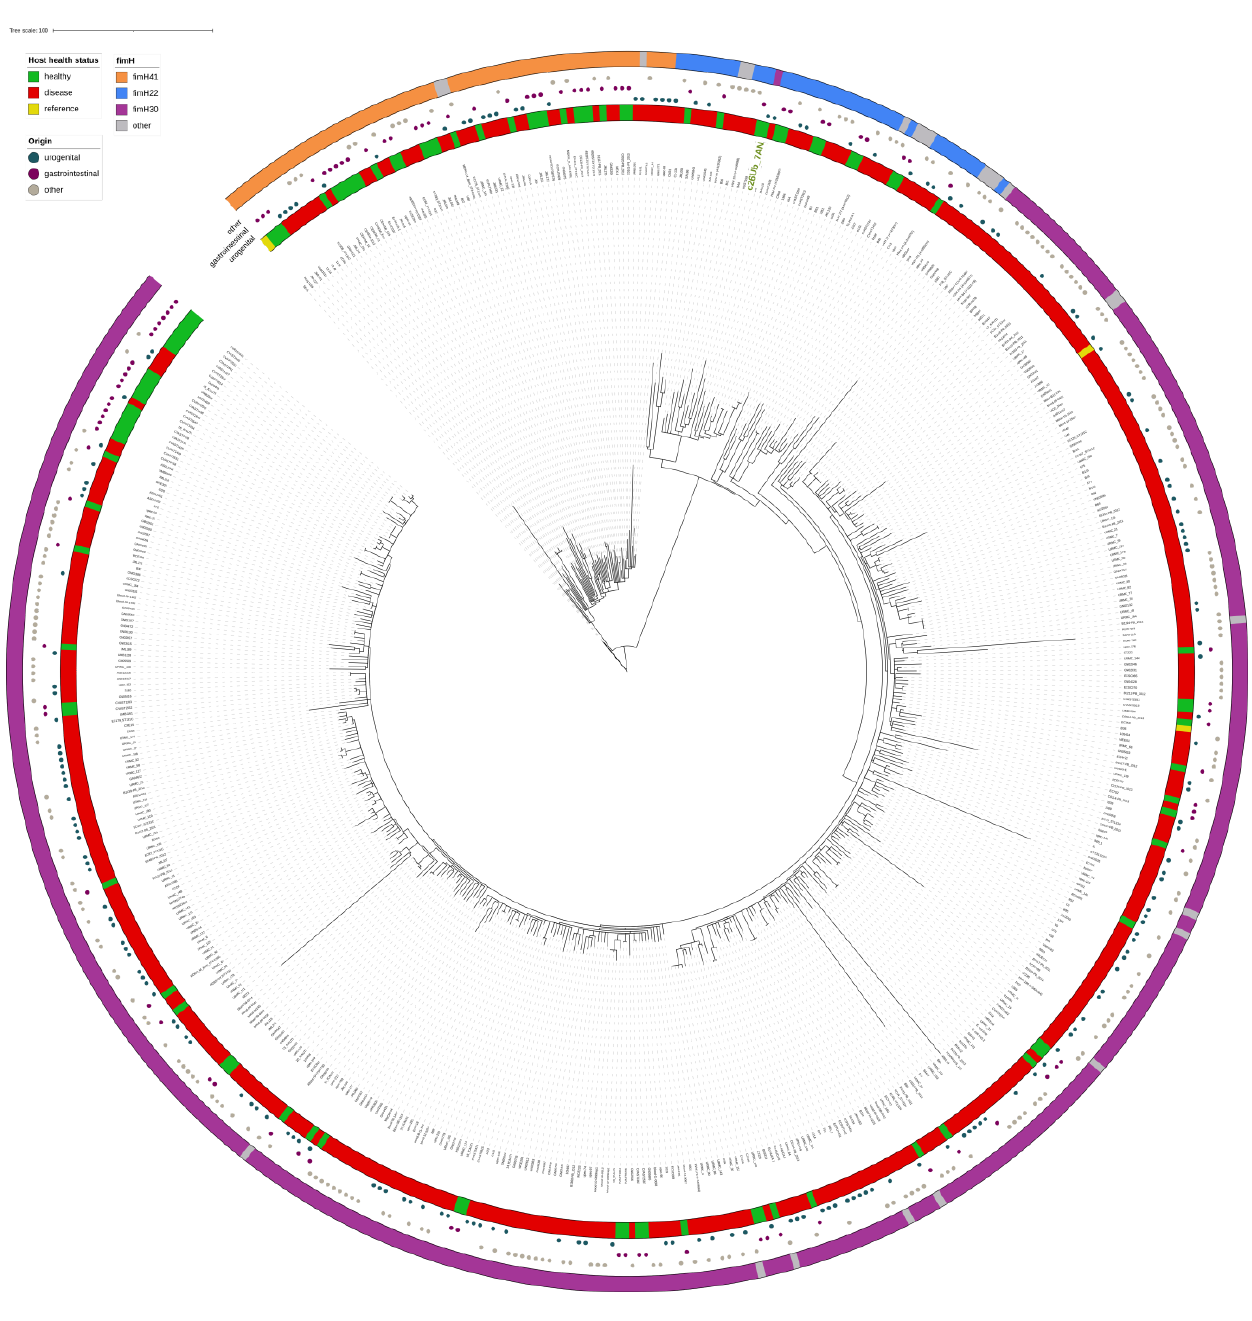
Figure 3. Core genome SNPs phylogenetic tree of 520 ST131 E. coli genomes of human origin. The phylogenetic tree includes 3 ST131 reference strains, i.e., SE15, JJ1886, EC958. The alignment was performed using E. coli strain EC958 as a reference and E. coli SE15 was used as an outgroup. The metadata including host health status, strain origin and fimH type are incorporated in the tree, as explained in the legend. The identifier of the strain from our urogenital collection is marked in green.